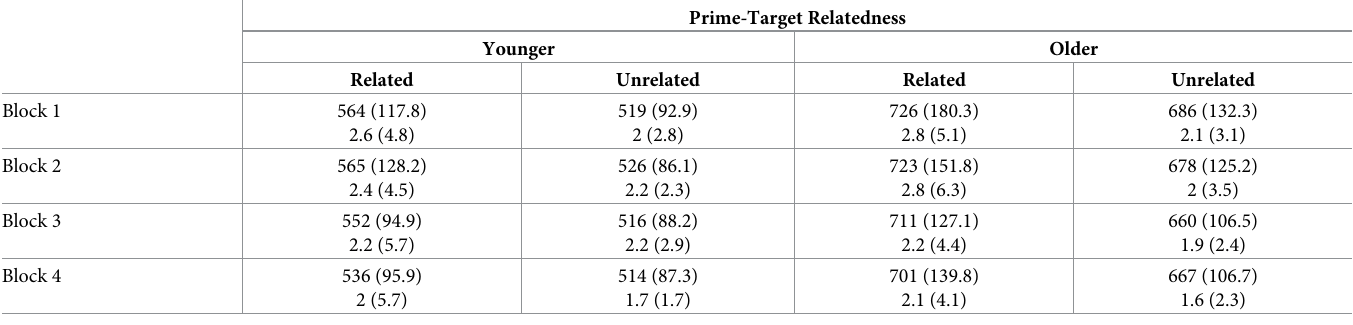
Table 7. Responses in the Congruency-Priming task for each